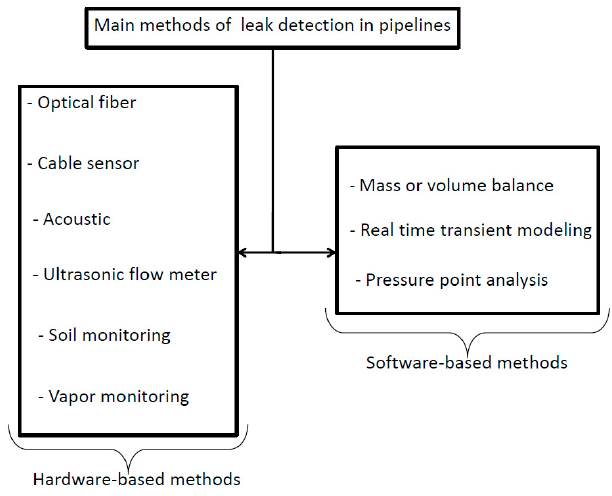
Figure 2. General classification of leak detection methods.